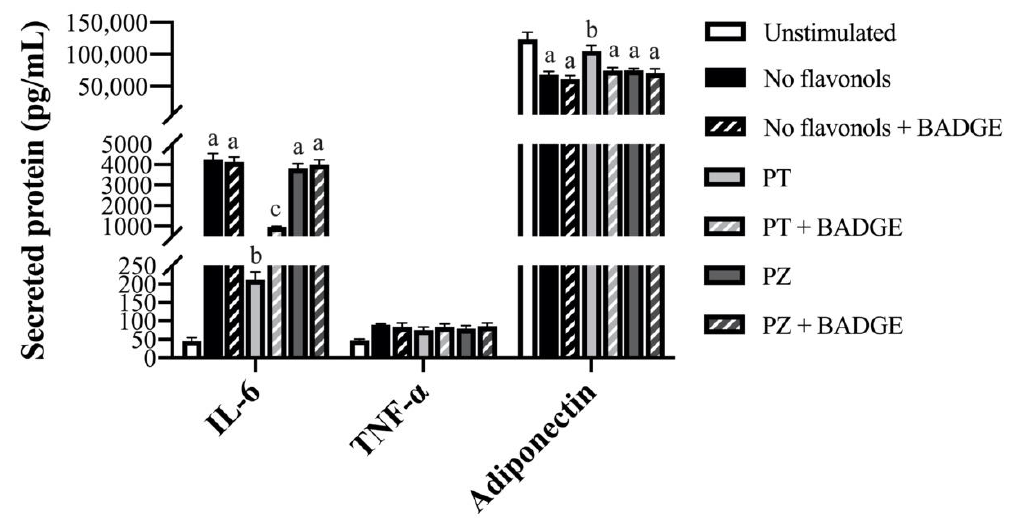
Figure 1. Secreted protein levels of inflammatory (interleukin (IL)-6 and tumor necrosis factor